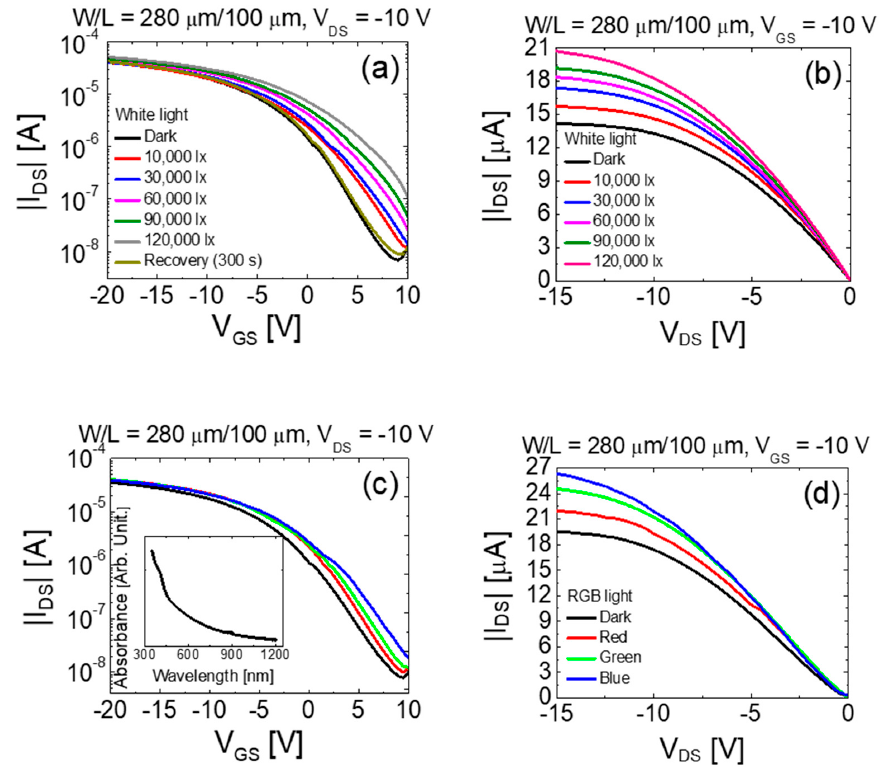
Figure 6. ( a ) transfer and ( b ) output curves of the vertically stacked bottom-gate SnO TFTs under white light illumination with different intensities. ( c ) transfer and ( d ) output curves of the SnO TFT under red-green-blue (RGB) light illumination. The RGB light intensity is fixed at ~6.5 mW/cm 2 . The inset of ( c ) shows the UV-vis absorption spectra of the deposited SnO thin-film.